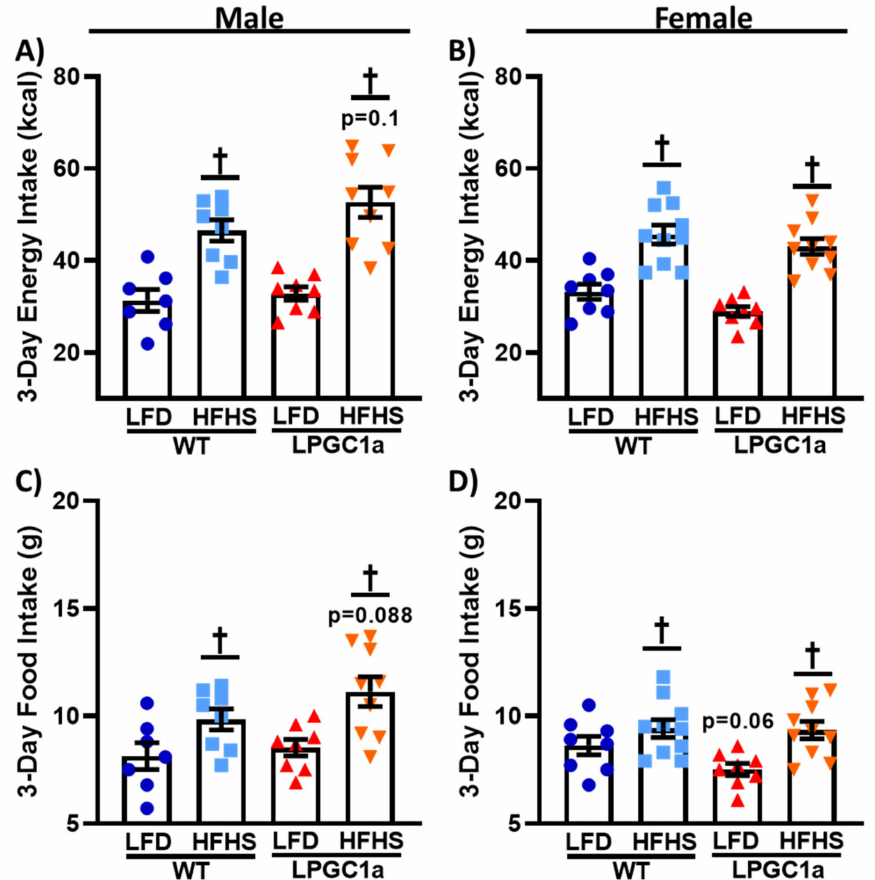
Figure 3. Reduced liver PGC1a subtly impacts HFHS food and energy intake in male mice. ( A , B ) Energy intake during the 3 days of indirect calorimetry was determined as the energy density of each diet (kcal/g) times the total ( C , D ) food intake (g) for male and female WT and LPGC1a mice, respectively. Individual data points and the group means ± SEM are displayed ( n = 7–10). † p < 0.05 main effect of